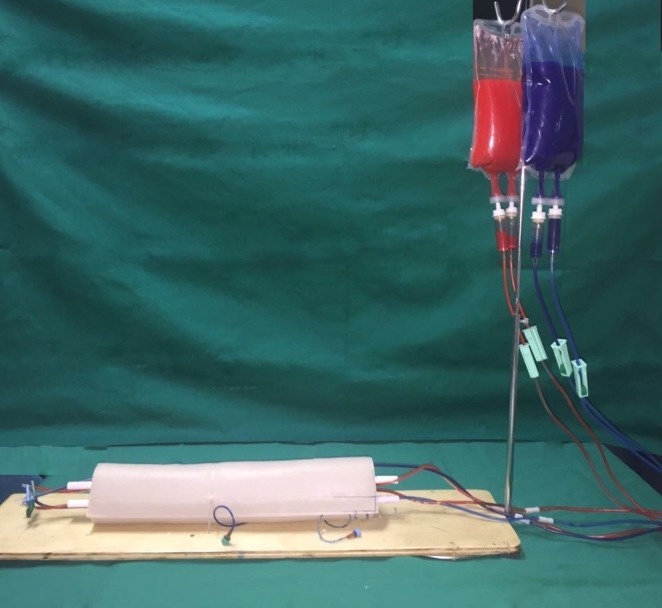
Final result: synthetic model of the forearm.